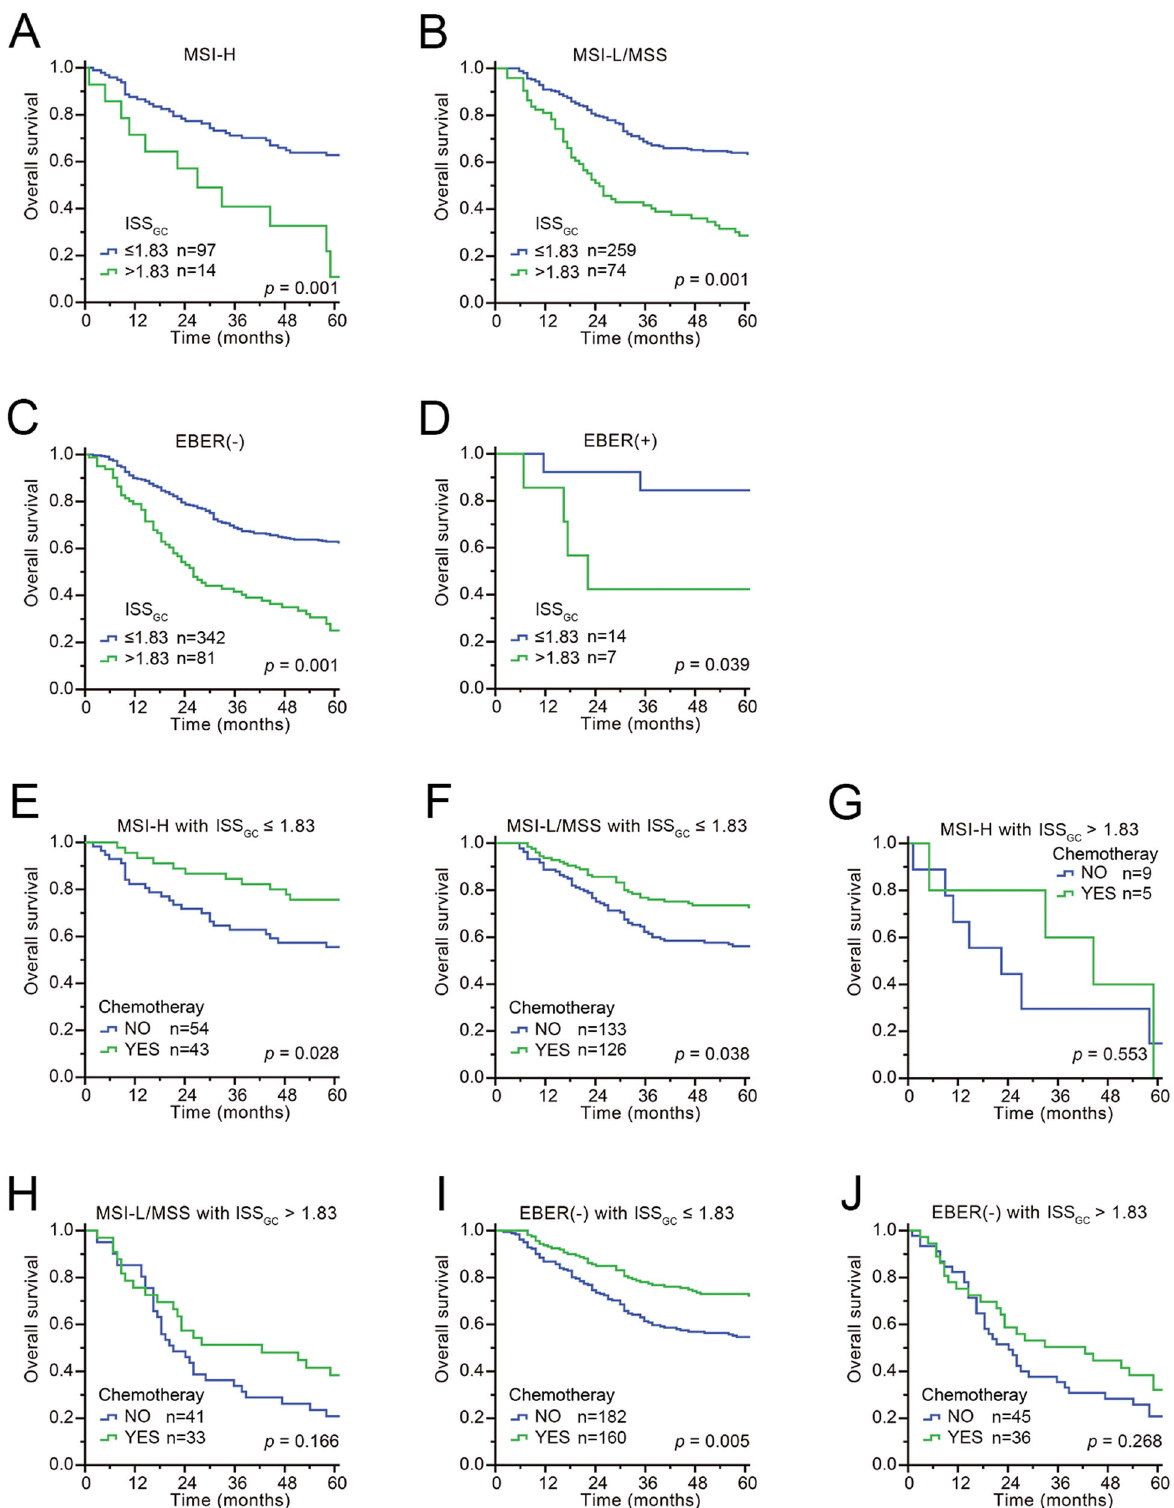
Fig. 5 Prognostic value of ISS GC score on gastric cancer patients and receipt of adjuvant chemotherapy strati fi ed by their MSI or EBV status. A , B Overall survival based on MSI status in GC patients after ISS GC strati fi cation is presented using Kaplan – Meier curves. C , D Overall survival based on EBV status in GC patients after ISS GC strati fi cation is presented using Kaplan – Meier curves. E – H Overall survival analysis of chemotherapy based on MSI status in GC patients after ISS GC strati fi cation is presented using Kaplan – Meier curves. I – J Overall survival analysis of chemotherapy in EBV-negative GC patients after ISS GC strati fi cation is presented using Kaplan – Meier curves. p -Values for all survival analyses have been calculated using the log-rank